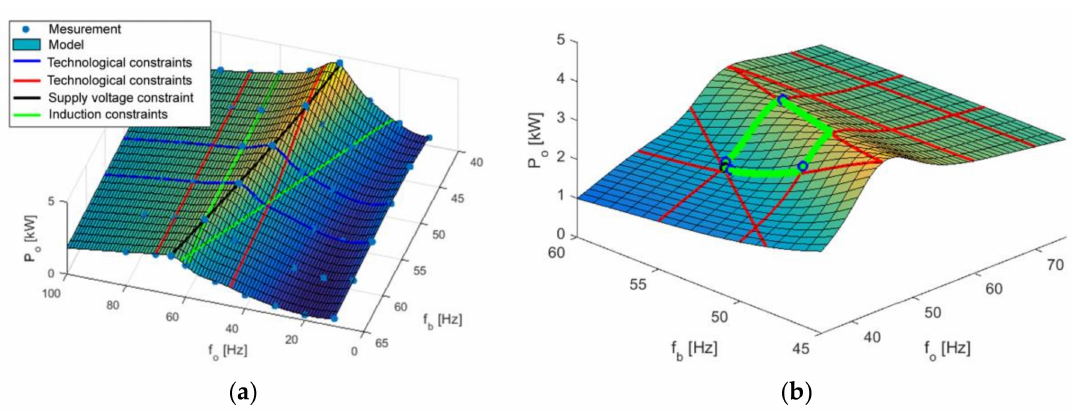
Figure 18. Example of measurements, model and constraints ( a ) of active power optimization and final